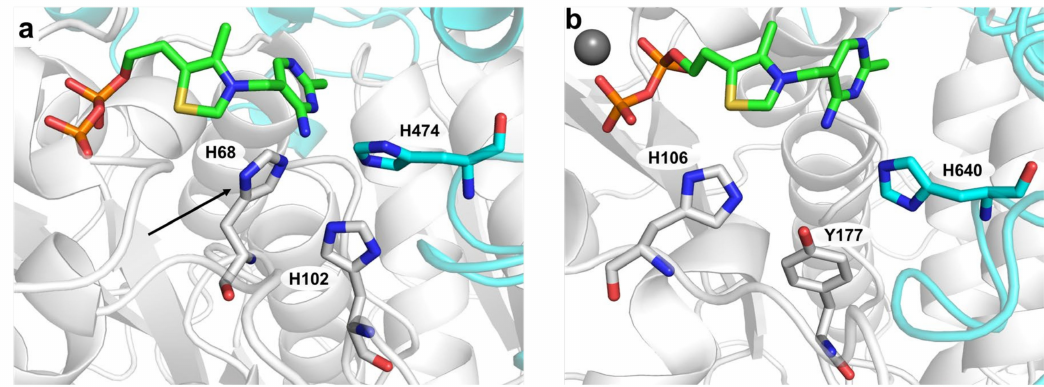
Figure 6. ( a ) Active site view of the homology model for TK GST . Residue H68 is essential for the activation of ThDP, whereas residues H102 and H474 were successfully mutated towards the conversion of aliphatic ketoacids [40]. ( b ) Active site view of Ec PDH E1 (2iea.pdb). The position of H102